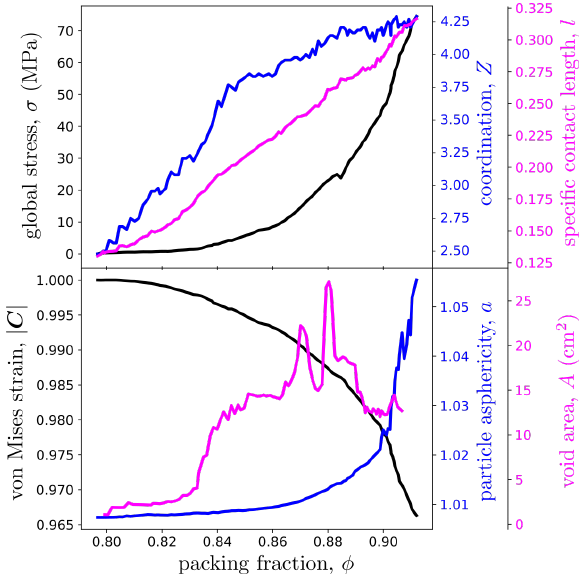
Figure 2. Global observables. Variation of the global stress ( σ ), coordination ( Z ), speci fi c contact length ( l ), average value of the von Mises of the right Cauchy-Green strain tensor ( particles, particle asphericity ( a ) and void area ( A ) as a function of the packing fraction ( φ ) for a compression experiment made with 50% of rigid particles ( κ = 0 . 5).